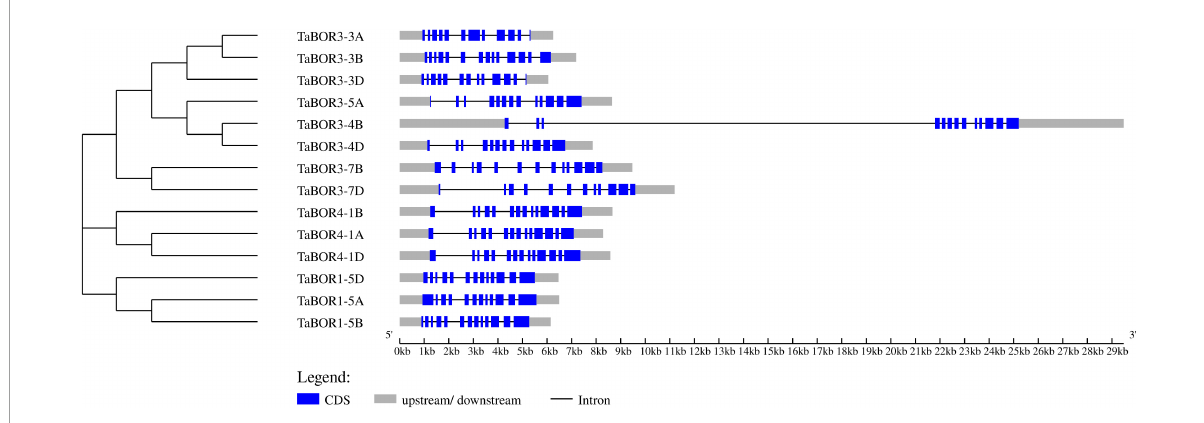
FIGURE2 Exon/intron distribution of the TaBOR family members. Blue boxes and gray lines represent exons and introns, respectively. Gray boxes indicate untranslated regions (UTRs).